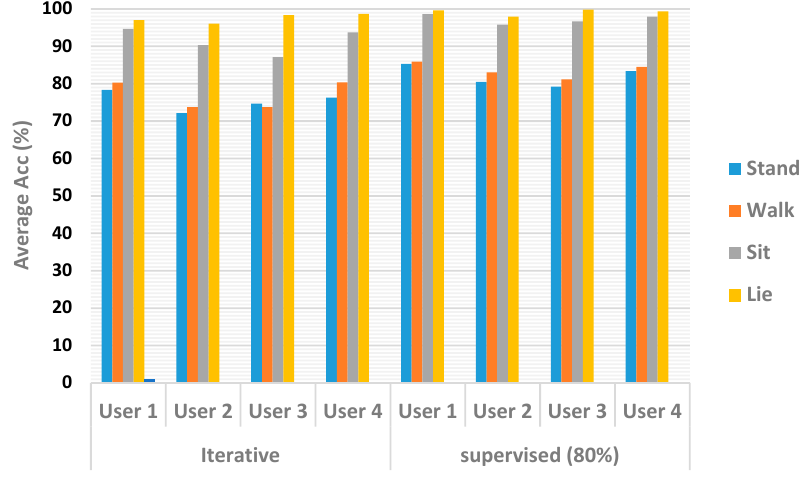
Figure 11. Classification model accuracy comparison between iterative and supervised methods.